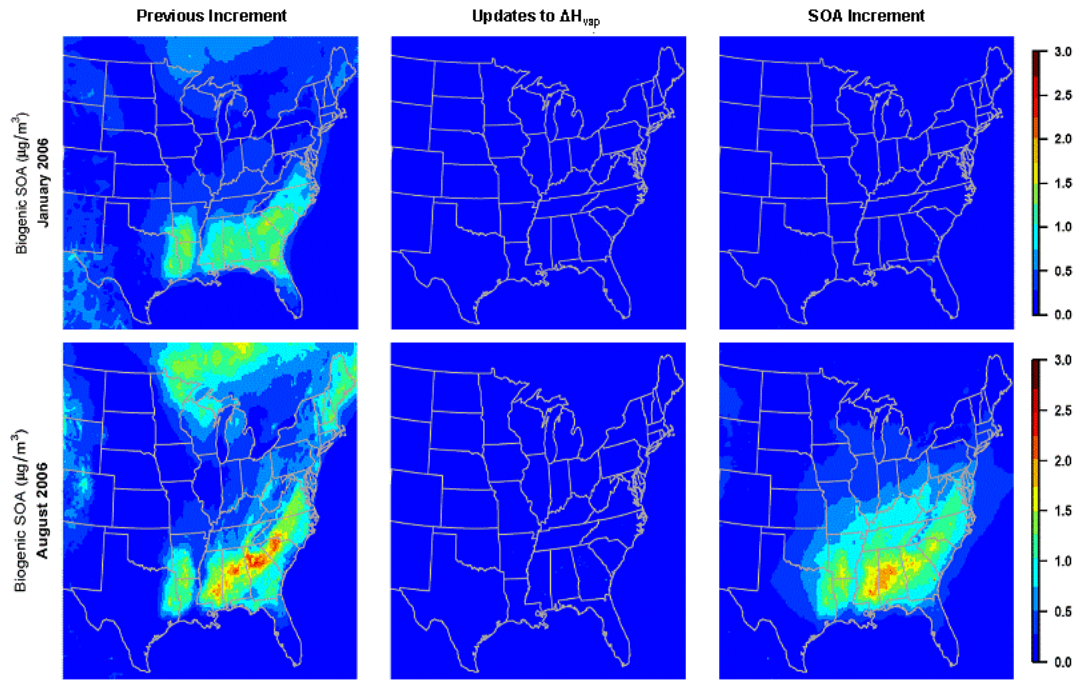
Fig. 3. Monthly average biogenic SOA (µg/m 3 ) for January (top row) and August (bottom row) 2006. The middle column shows the effect of reducing the enthalpies of vaporization ( 1 H vap ) compared to the previous increment (left column). The right column shows results from the final SOA module described in Sect.